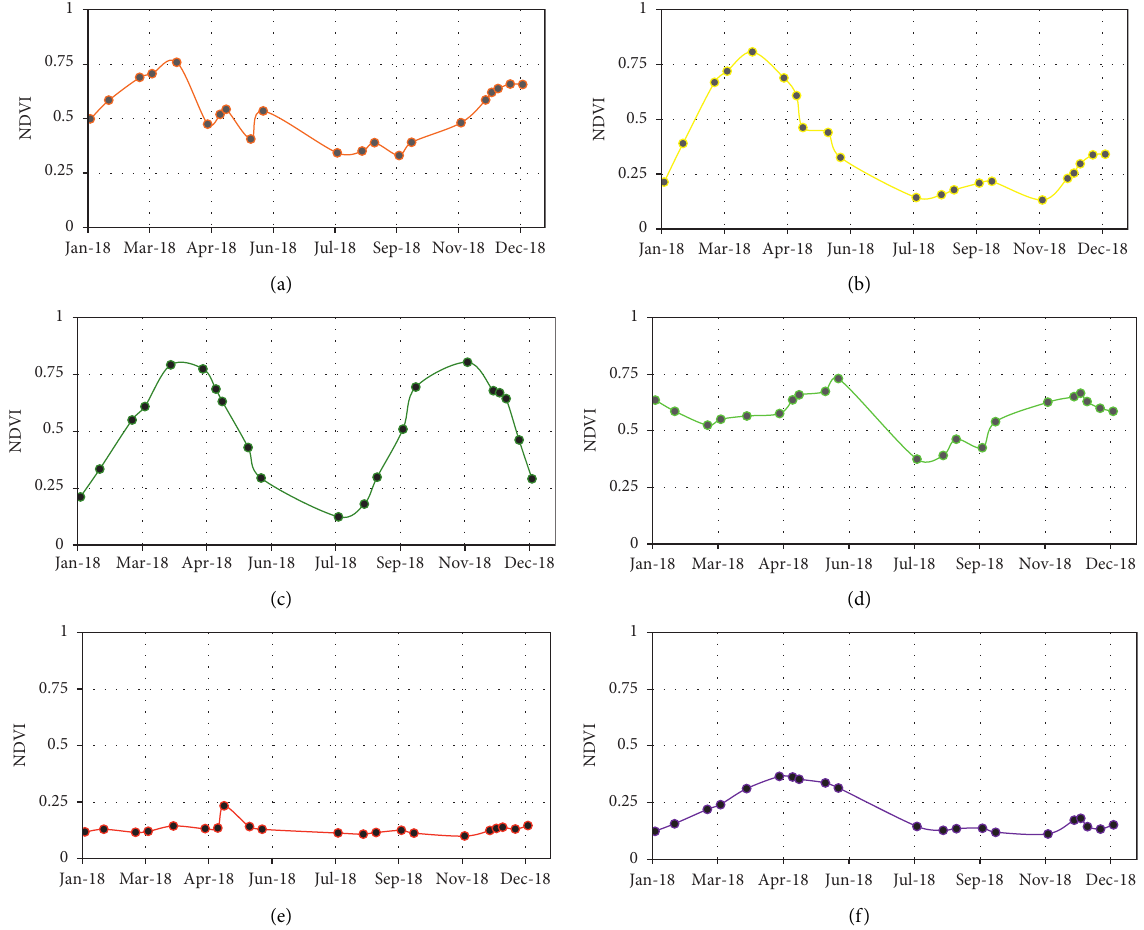
Figure 6: NDVI profiles of the different classes chosen in zone R3 for the year 2018. (a) Oranges. (b) Cereal. (c) Double cropping. (d) Olive. (e) Bare soil. (d)